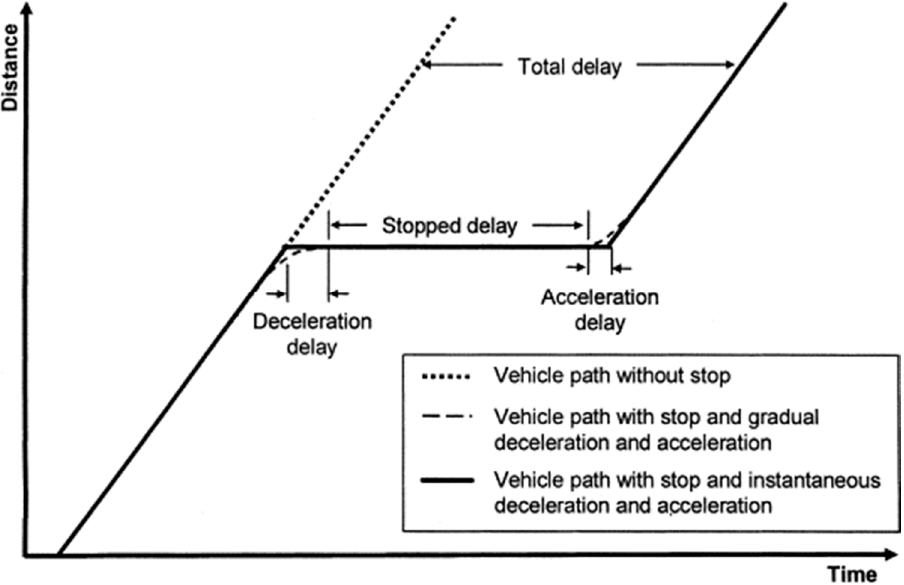
Figure 2. Vehicle delay at intersection.